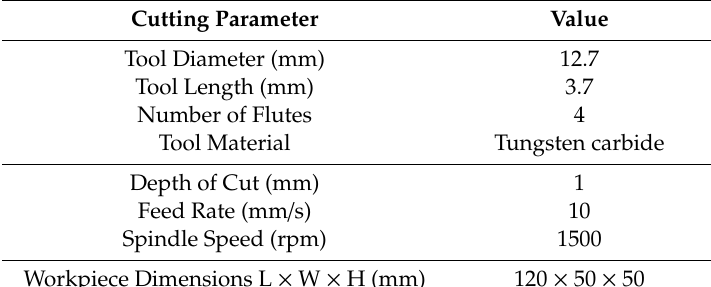
Table 4. Cutting Parameters of the Milling Test.